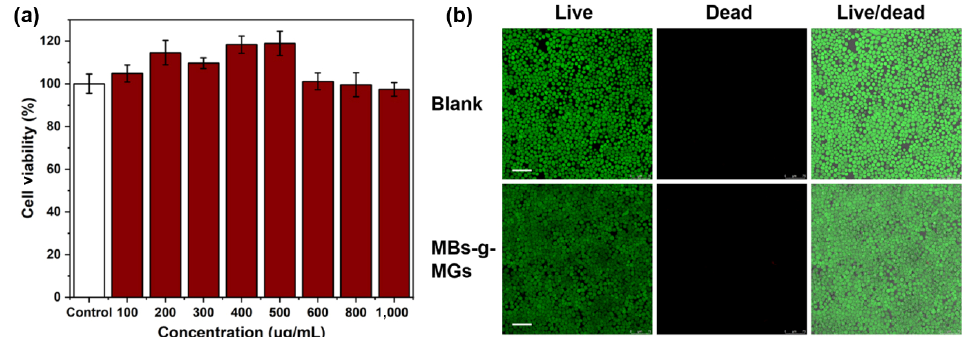
Fig. 7 (a) Cell viability of HepG2 cells incubated with different concentrations of MBs-g-MGs for 24 h. (b) Live/dead staining of HepG2 cells after incubation with MBs-g-MGs for 24 h detected by the CLSM. Scale bar: 75 μ